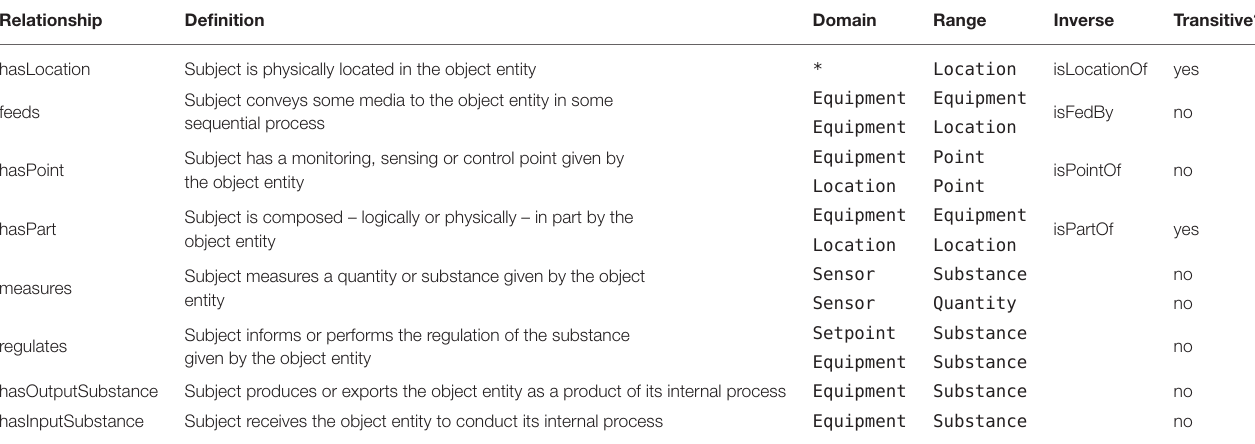
TABLE 2 | List of high-level relationships supported by Brick+.